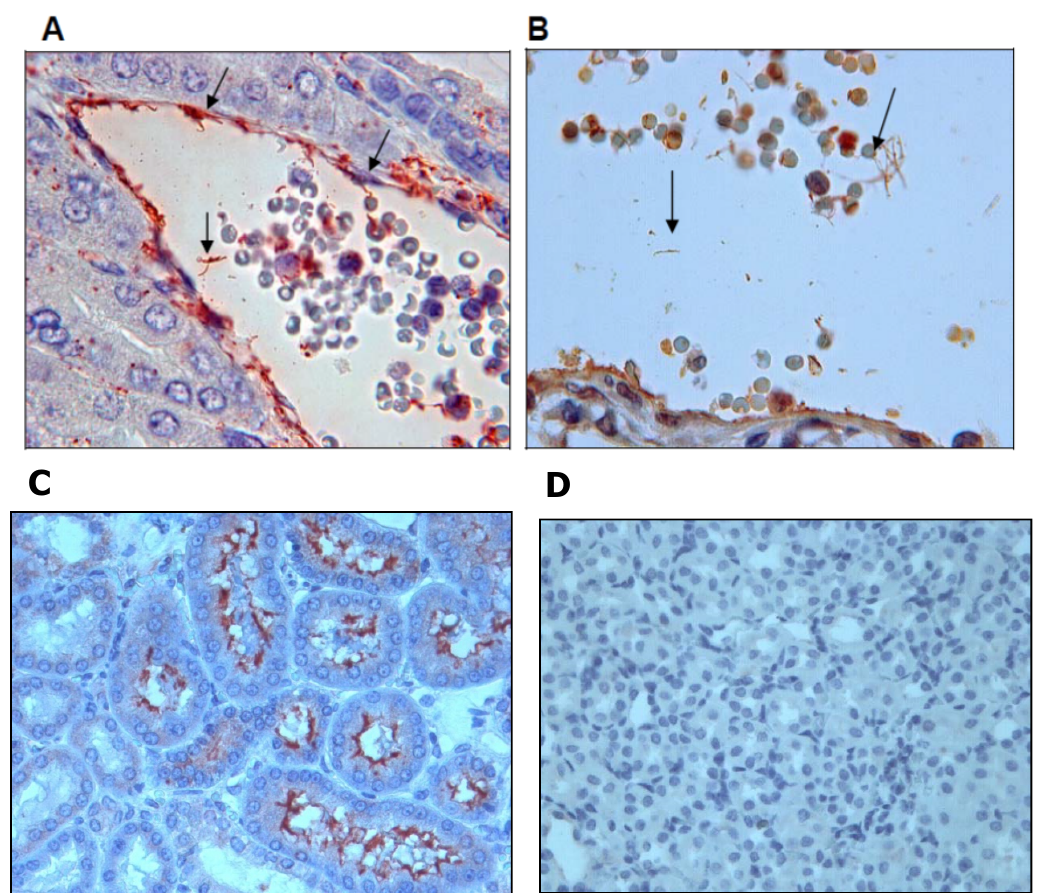
Figure 5. Immunohistochemistry assay on renal tissue of experimentally infected hamsters ( Mesocricetus auratus ). Infection was performed by intraperitoneal inoculation with the virulent strain LOCaS46 of Leptospira interrogans serovar Canicola. Panels ( A , C ): Detection of leptospires using a 1:200 dilution of rabbit polyclonal hyperimmune antiserum against L. interrogans serovar Canicola. Panel ( B ): Detection of leptospires using a 1:25 dilution of the rabbit polyclonal antibody against the recombinant GspD secretin of L. interrogans serovar Canicola (rGspDLC). Panel ( D ): Renal tissue of a non-infected hamster used as a control.